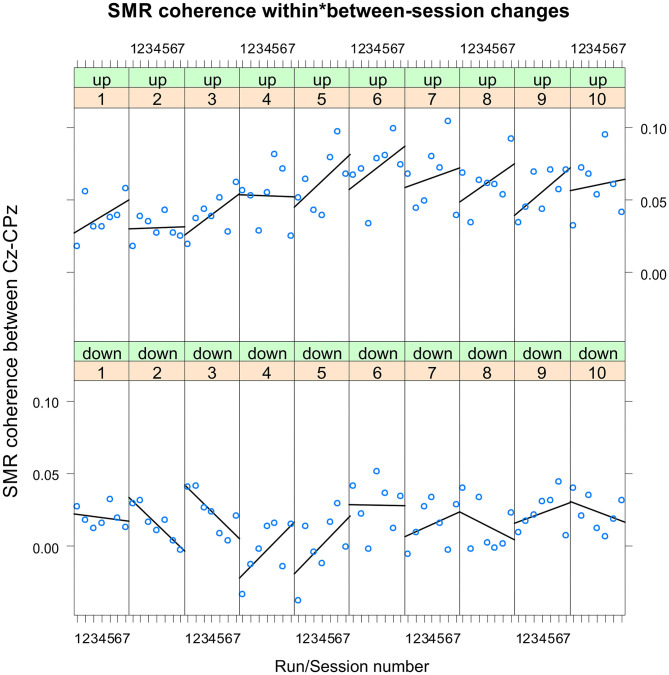
Neurofeedback training performance per training session. Changes in SMR coherence between Cz and CPz across feedback runs (within-session changes, run 1 = baseline run, run 2 = 1st feedback run, run 7 = 6th feedback run), presented separately per neurofeedback training session (1–10) and group (up-regulation group: upper panel, down-regulation group: lower panel).